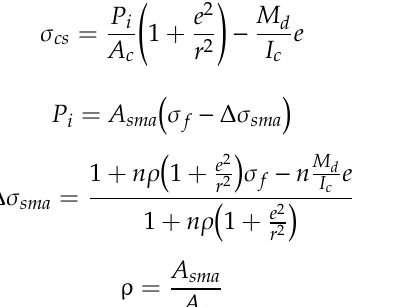
Figure 8. Comparison of temperature ‐ recovery stress curves by heating temperature under rigid restraint.